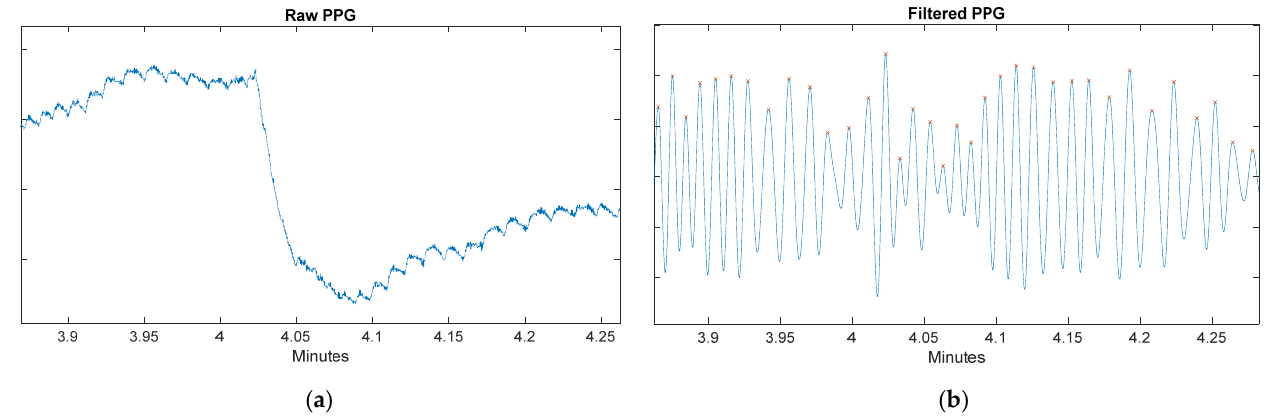
Figure 16. ( a ) Raw PPG signal during toothbrushing at the fourth minute; ( b ) Filtered PPG signal during toothbrushing at the fourth minute. The correct detection of the marked peaks can also be observed.